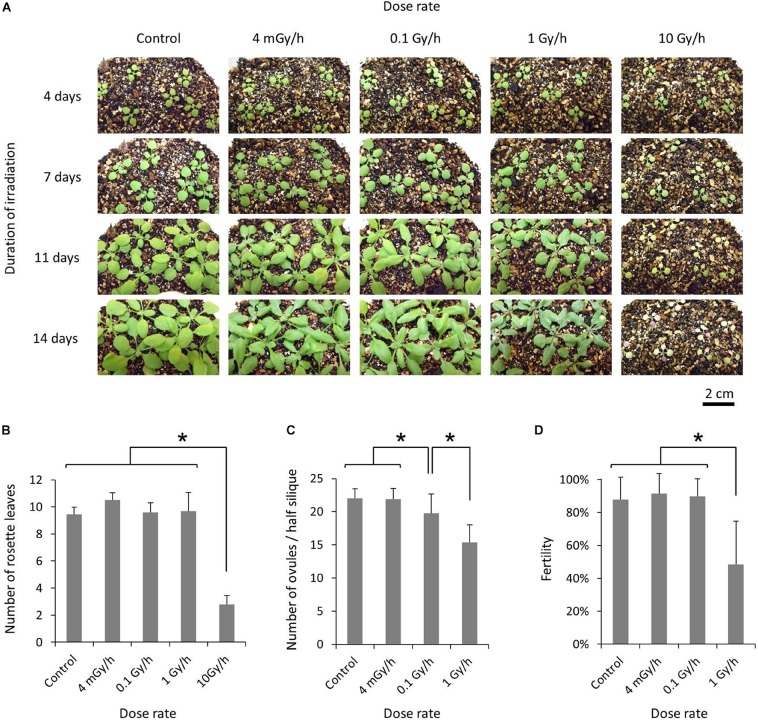
Effects of chronic gamma irradiation on the growth of Arabidopsis plants. (A) Plants grown from 7 days after seed sowing under a gamma ray environment with the indicated dose rate and duration. The scale bars represent 2 cm for all the panels. (B) Number of rosette leaves per plant examined after the termination of a 14-days irradiation treatment. Data represent means ± standard deviations of 9–10 plants per treatment. (C,D) Number of ovules per half silique (C) and the percentage of fertilized ovules (D). After a 14-days irradiation treatment, plants were placed in a growth room without gamma irradiation. The total number of ovules and the number of fertilized ovules on one side of the septum were determined for each silique, using the 3rd–5th siliques from the base. Data represent means ± standard deviations of 24–30 siliques collected from 8 to 10 plants per treatment. *Significantly different (t-test, p < 0.01).